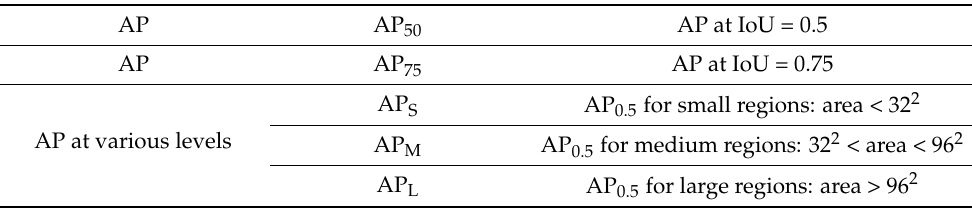
Table 3. Microsoft’s COCO benchmarks—widely used in object detection tasks to evaluate precision and recall at various